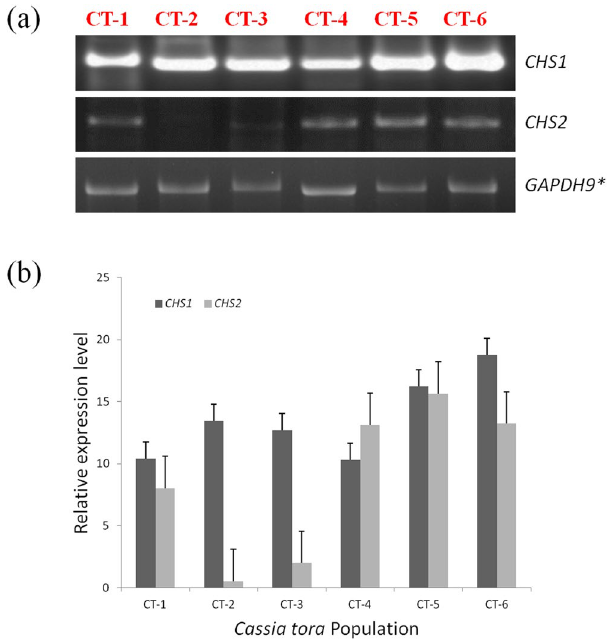
Figure 7. RT-PCR of Chalcone synthase (CHS) gene: ( a ) visualization of amplified genes ( b ) Relative transcript expression level in C. tora leaves of the six accessions was determined. Error bars indicate the standard error of the mean ± SE of three replicate measurements. ( * control